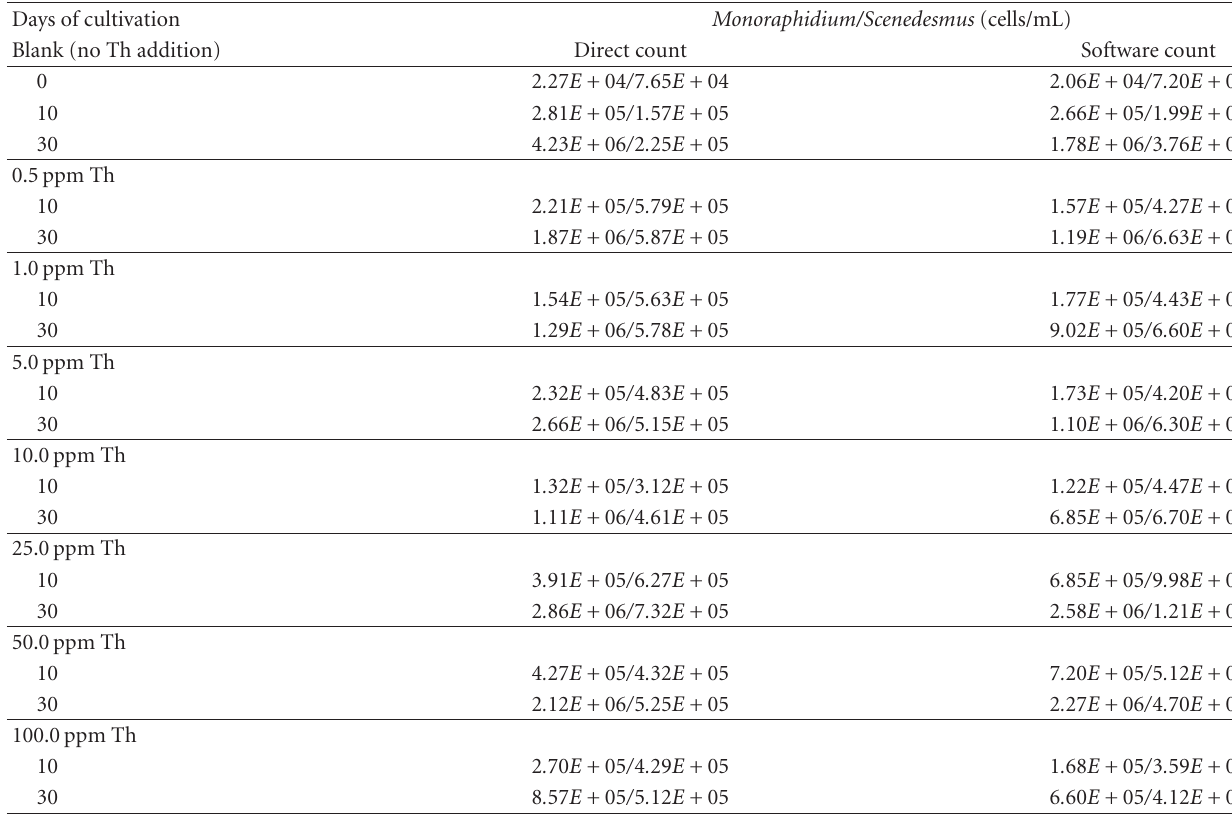
Table 3: Comparison between direct cell counts and software